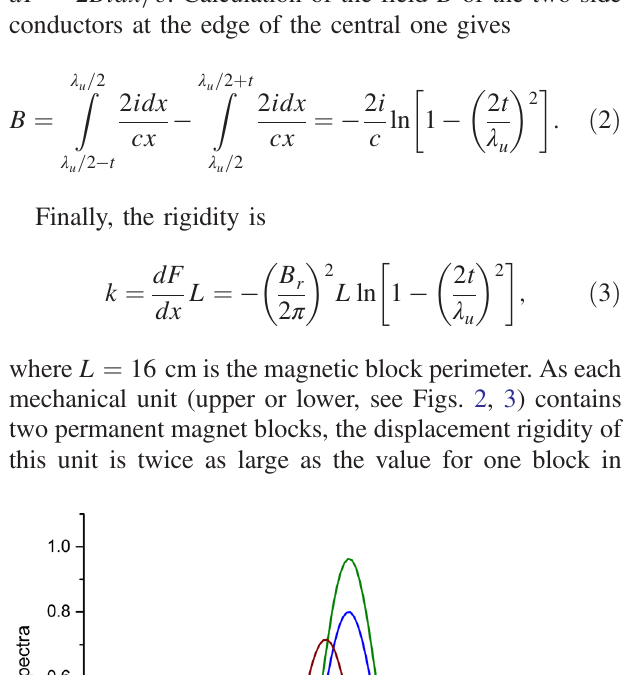
FIG. 11. Three blocks of pure permanent magnet undulator. The central one is slightly shifted longitudinally.